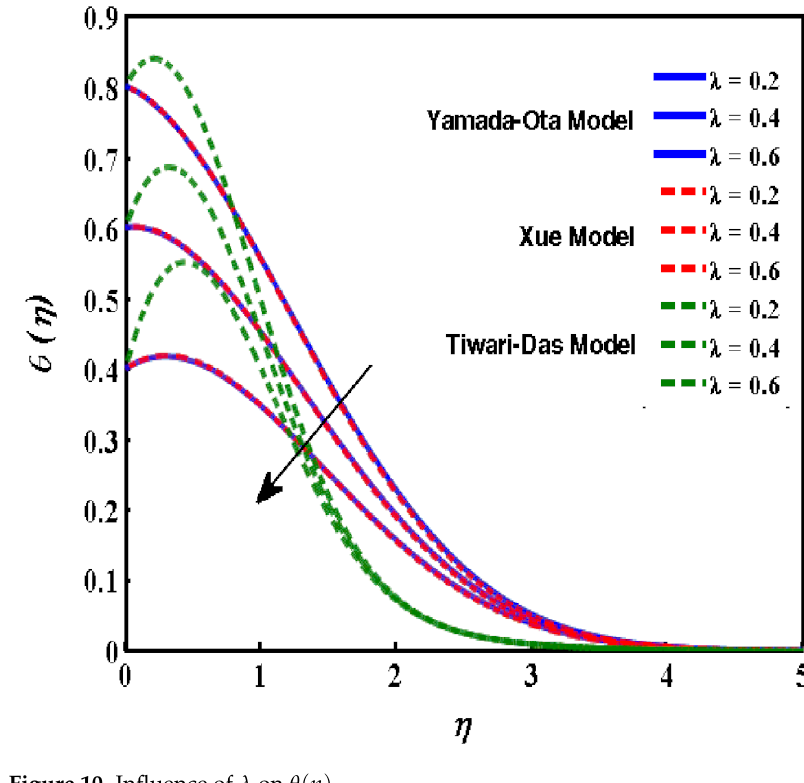
Figure 10. Influence of λ on θ ( η ) .